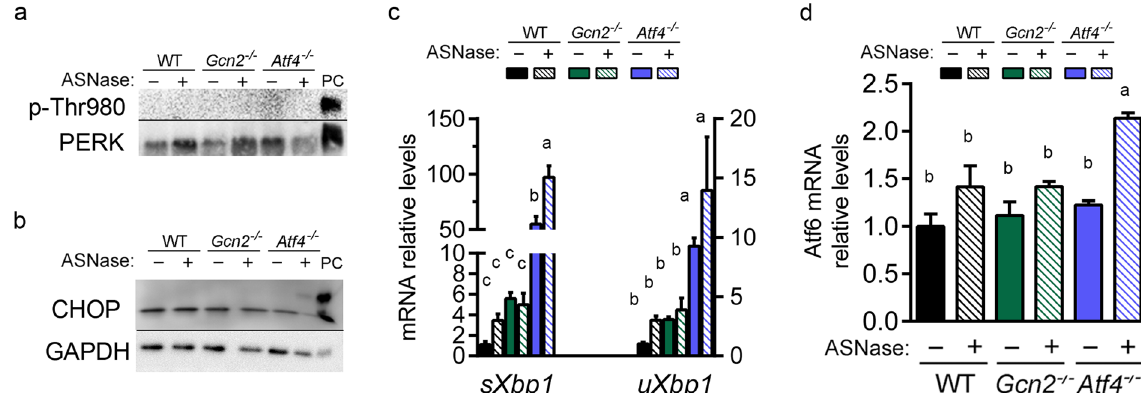
Figure 4. Atf4 deletion selectively engages the UPR following 8 daily injections of asparaginase (3 IU per gram body weight, ASNase) or phosphate buffered saline excipient (PBS) in wild type mice (WT) or mice deleted for Gcn2 ( Gcn2 − / − ) or Atf4 ( Atf4 − / − ). ( a ) Phosphorylation of PERK in liver by immunoblot analysis. ( b ) CHOP protein expression by immunoblot analysis. ( c ) Gene expression of spliced (s Xbp1 ) and unspliced (u Xbp1 ) Xbp1 mRNA measured by RT-qPCR. ( d ) Atf6 mRNA levels measured by RT-qPCR. Data are represented as the average value ± standard error of the mean, n = 3–4 per group. Means without a common letter are different according to Tukey post hoc analysis following ANOVA, P < 0.05. PC, liver from a tunicamycin-treated mouse as positive control. Full immunoblots are presented in Supplementary Figure S7.